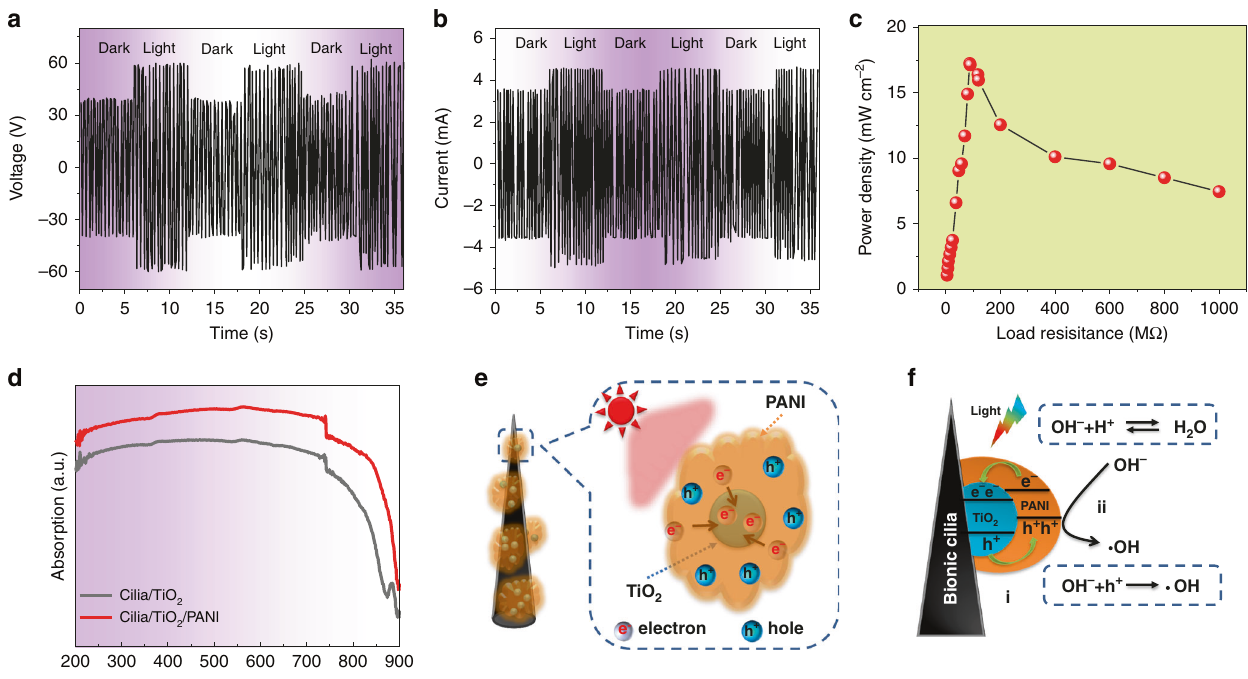
Fig. 3 Electrical performance and photoelectric mechanism of Pem-iTENG. a The curve of open-circuit voltage under dark/light cycle. b The curve of short-circuit current under dark/light cycle. c Dependence of output power density of Pem-iTENG on the resistance of external load under light irradiation. d Absorption spectrum of Pem-iCM. e Schematic illustration of electron-hole separation and transport between TiO 2 and PANI. f Schematic illustration of charge transfer and photocatalysis